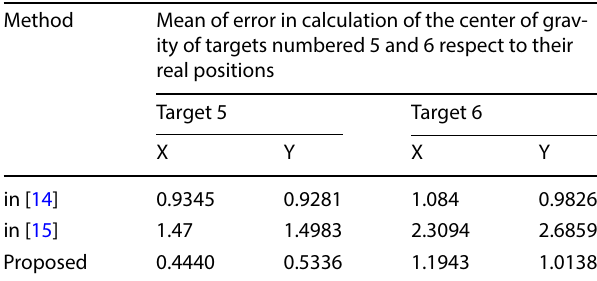
Table 8 Comparison of mean of errors in calculation of the center of gravity of targets numbered 5 and 6 by the proposed method, and methods in [14] and [15] Method